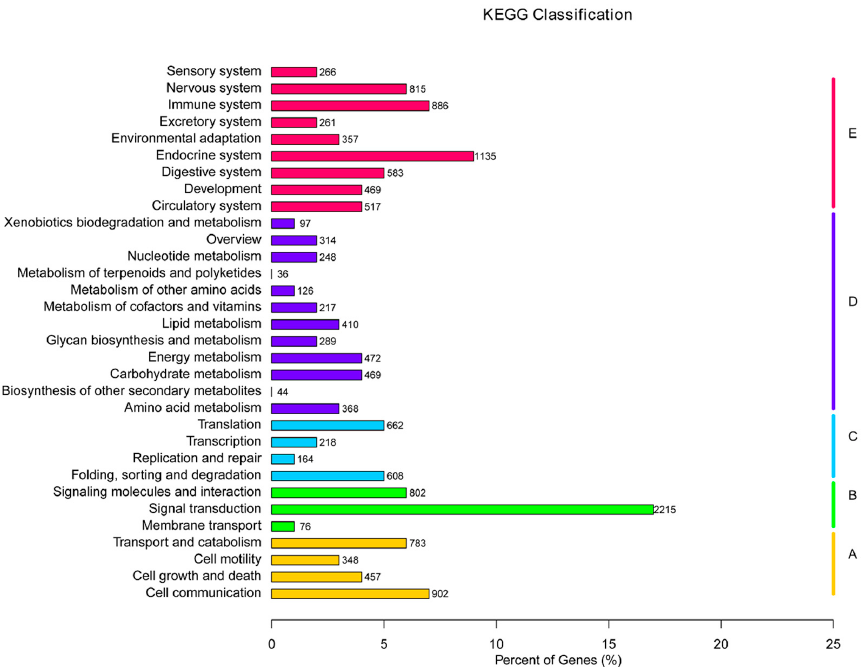
Figure 4. KEGG classification of the 23,468 unigenes. Five capital letters with the corresponding colored bars indicate five main categories. A : cellular processes; B : environmental information processing; C : genetic information processing; D : metabolism; E : organism systems.